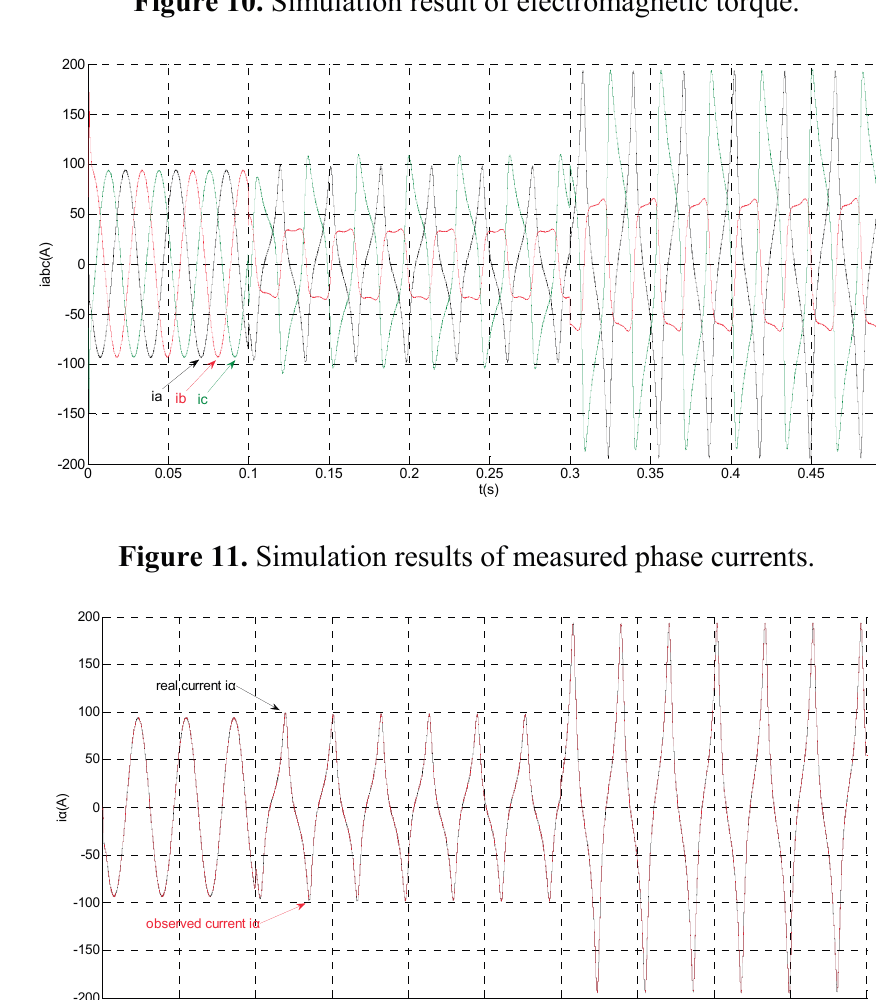
Figure 10. Simulation result of electromagnetic torque.